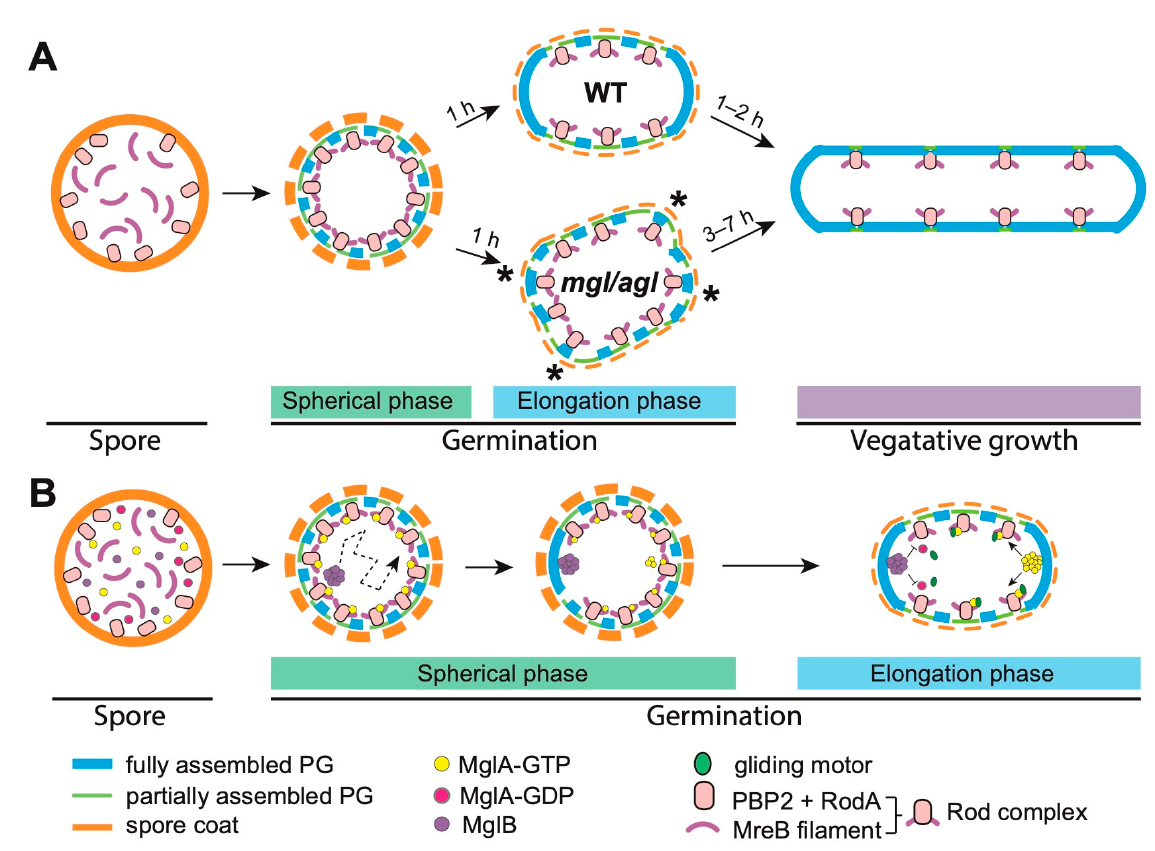
Figure 1. A schematic model for the de novo establishment of rod-shape from spherical, PG-deficient spores. ( A ) As the wild-type (WT) spores germinate, nascent cells restrict Rod complexes, and thus PG assembly, to non-polar regions in the elongation phase of germination. Such a pattern of PG growth maintains the integrity of cell surfaces and restores vegetative morphology within 3 h. In contrast, in the mgl spores (from the strains of ∆ mglA , ∆ mglB , and mglA Q82L that encode a GTPase-inactive variant of MglA, and mglB OE that overexpresses MglB) and the agl spores that express truncated gliding motors, the localizations of Rod complexes and PG assembly are not restricted. As a result, such spores grow into bulged intermediates that are sensitive to osmotic stresses and restore vegetative cell shape much more slowly (4–7 h). The asterisks mark the sites where Rod complexes mislocalize and bulges appear. ( B ) Symmetry breaking by MglB and MglA. The GTP-bound form of MglA (MglA-GTP) connects to Rod complexes via MreB filaments. Through the mutual expulsion between MglB and MglA-GTP, MglB clusters survey the status of PG synthesis indirectly, and cannot localize at the sites where PG assembly is active and Rod complexes are present. Therefore, MglB clusters move randomly in the early spherical phase, when Rod complexes distribute randomly on cell surfaces. Once a patch of PG is completely assembled and the Rod complexes leave, the MglB cluster will stall at this site, which will become the first future pole. At the first pole, MglB expels MglA-GTP, and thus the Rod complexes, toward the second pole. MglA-GTP then occupies the second pole, stimulating the assembly of the gliding machineries, which transport MreB filaments, together with Rod complexes, toward the first pole. As a result, the diametrically opposing clusters of MglA-GTP and MglB restrict the Rod system, and thus the assembly of PG, to non-polar locations.